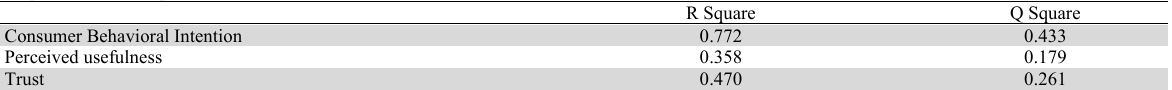
R square and Q square